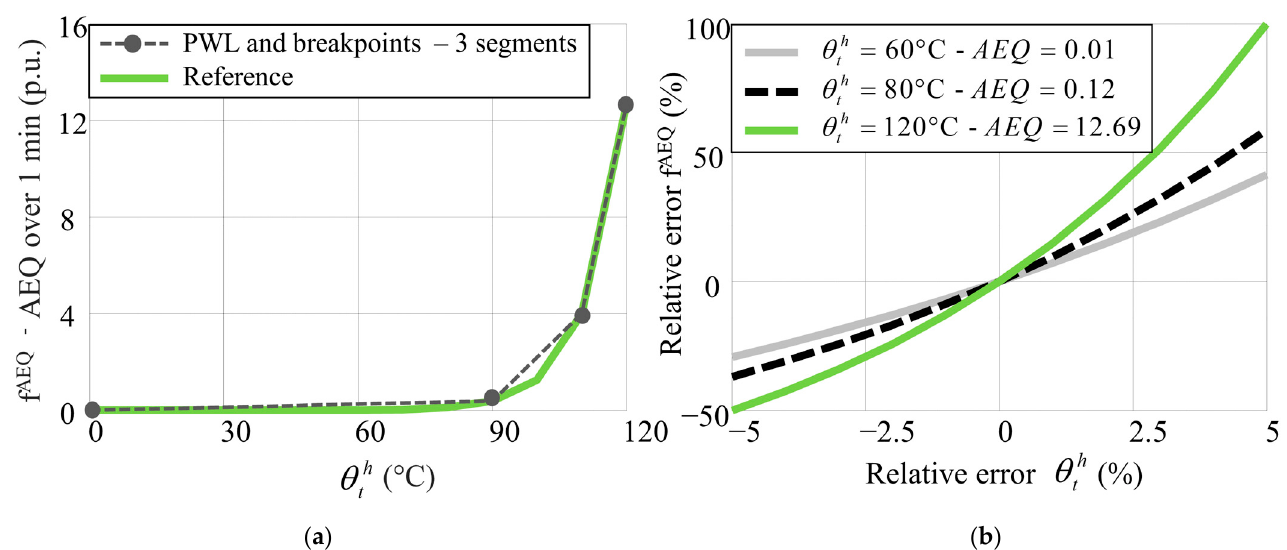
Figure 8. PWL process: ( a ) functions fitting and breakpoints for f AEQ ; ( b ) aging function—f AEQ error versus θ h error.